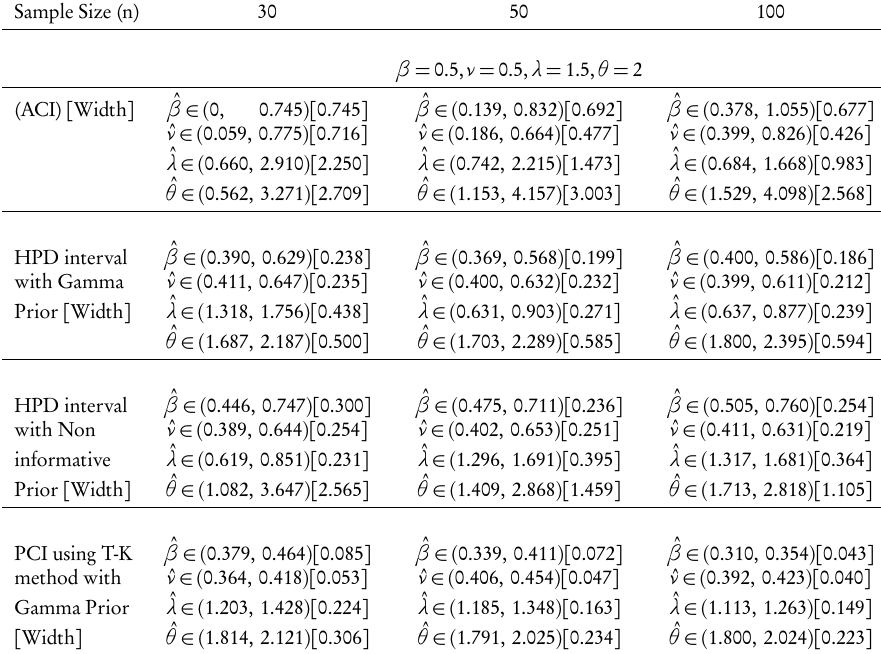
Various confidence intervals with their corresponding